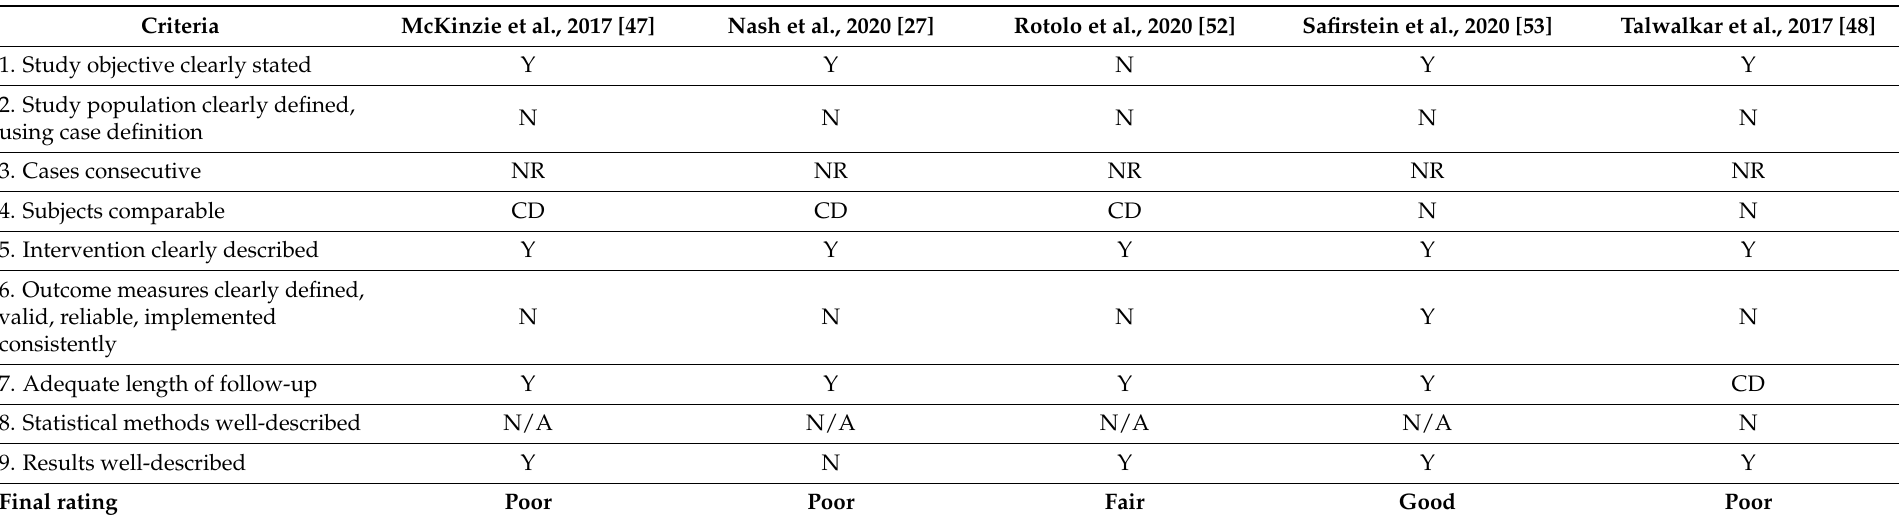
Table A2. Summary of methodological ratings of included case series